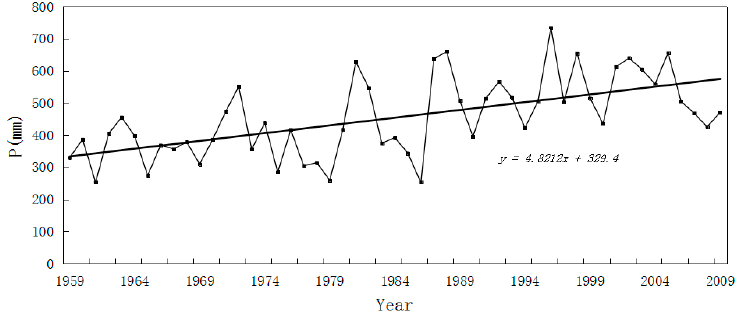
Figure 7. Reconstructed yearly average precipitation ( P ) at Camp ‐ AWS over the period 1959–2009.